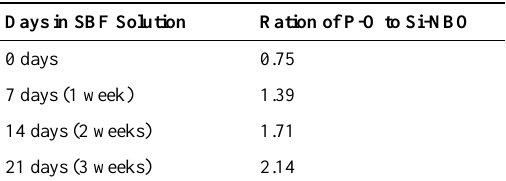
Figure 9. FTIR Spectrum of SBF immersed Bioglass Pellet Table 1. Ratio of P-O bond to Si-NBO Bond